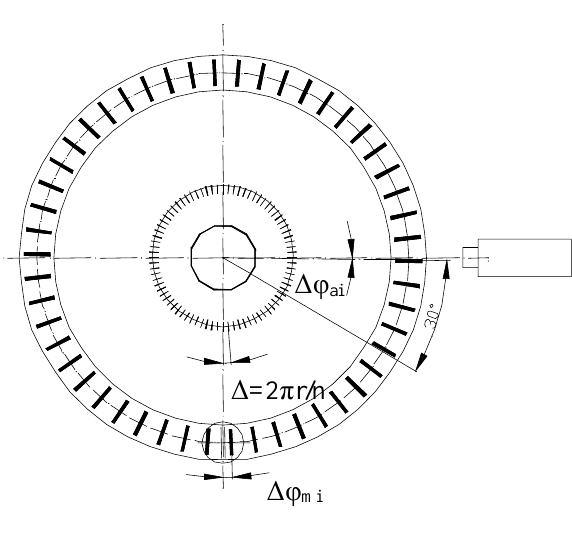
Fig 1 . The diagram of circular scale